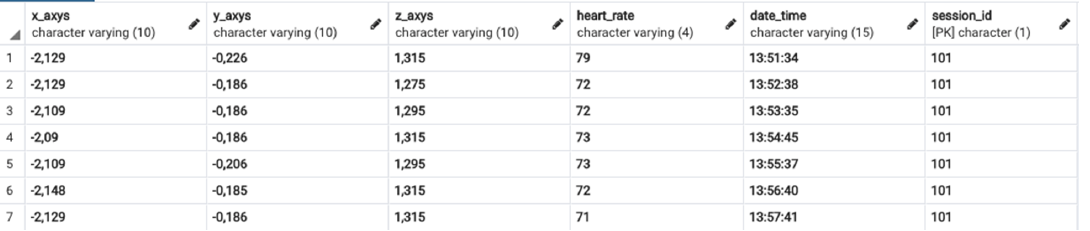
Figure 26. Example of data in the “Sensor_Data” table.